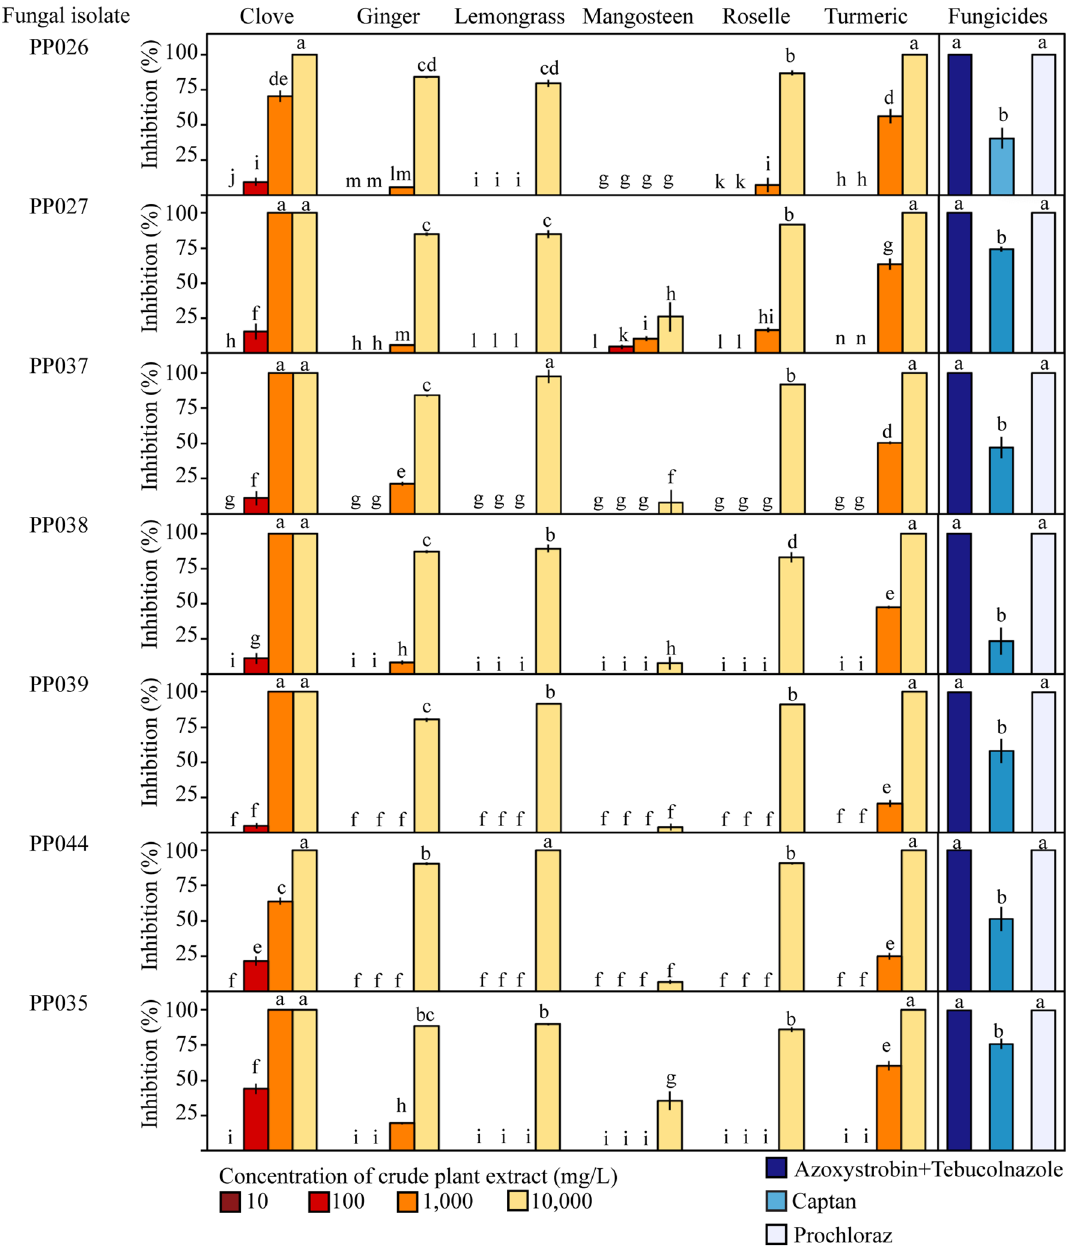
Figure 6. Effect of six crude plant extracts (clove, ginger, lemongrass, mangosteen, roselle, and turmeric) at concentrations of 10, 100, 1,000, and 10,000 mg/L on mycelial growth inhibition of Neopestalotiopsis (PP026, PP027, PP037, PP038, PP039, and PP044) and Pseudopestalotiopsis (PP035) compared to inhibition of azoxystrobin + tebucolnazole, captan, or prochloraz fungicides. Same lowercase letters represent no significant difference (P <